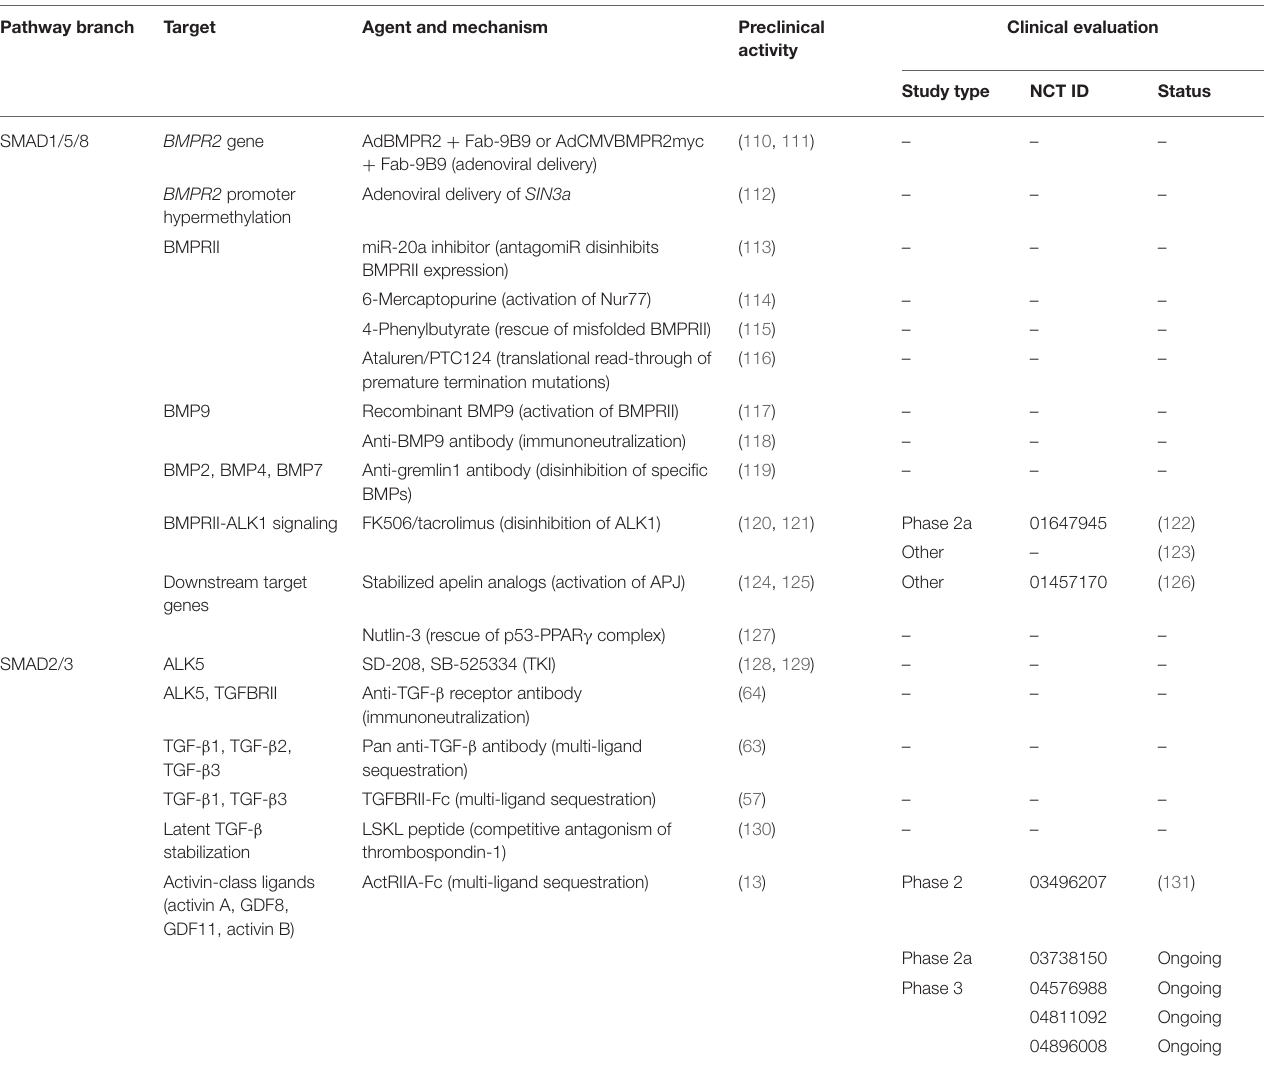
TABLE 1 | Agents targeting canonical TGF- β superfamily pathways for